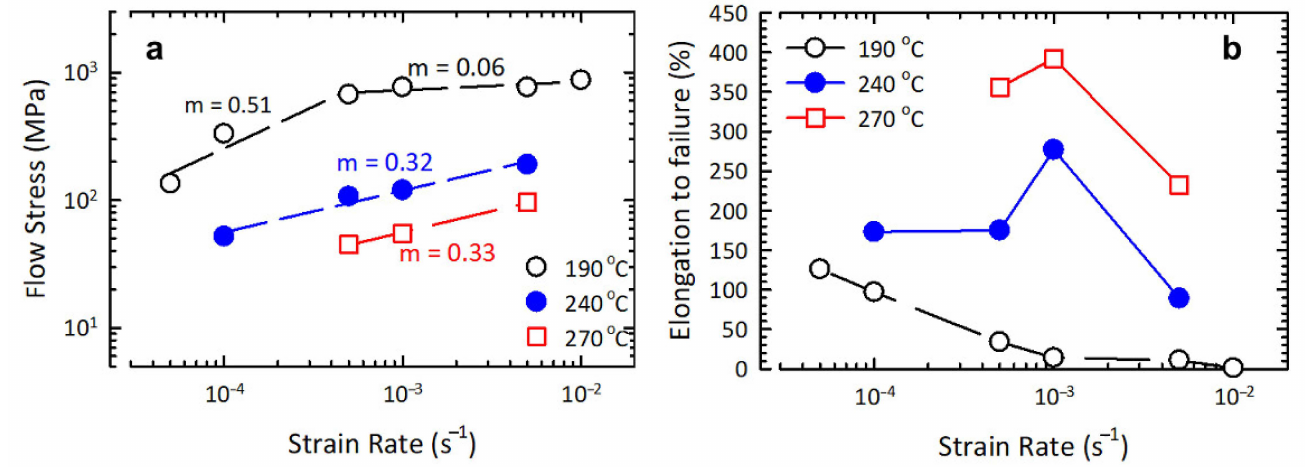
Figure 5. Dependence of flow stress on strain rate ( a ) and elongation on strain rate ( b ), based on the results of static tests at 190, 240 and 270 ◦ C of the UFG Al 2024